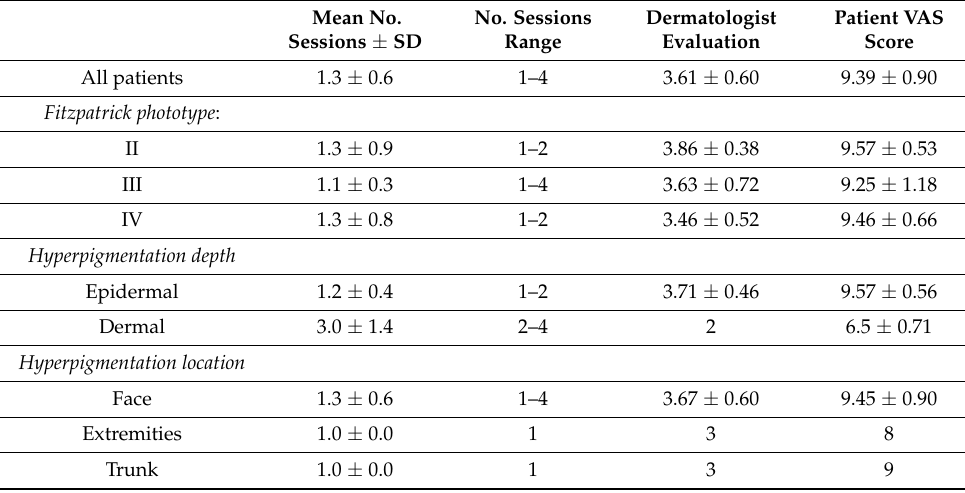
Table 2. Clinical parameters and removal scores in different